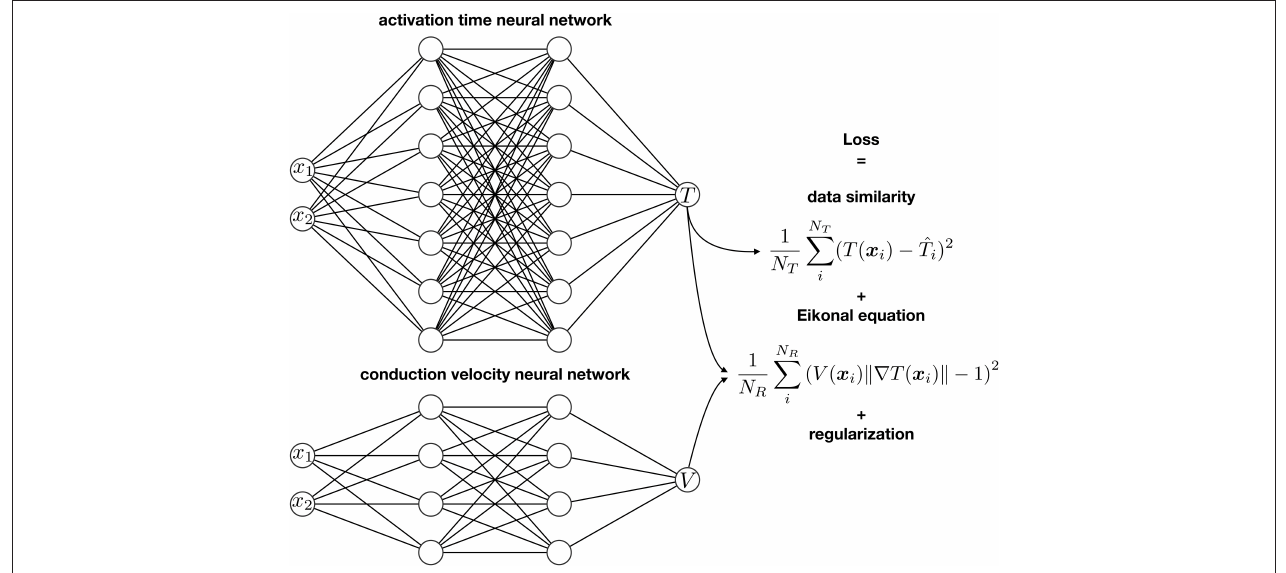
FIGURE 1 | Physics-informed neural networks for activation mapping. We use two neural networks to approximate the activation time T and the conduction velocity V . We train the networks with a loss function that accounts for the similarity between the output of the network and the data, the physics of the problem using the Eikonal equation, and the regularization